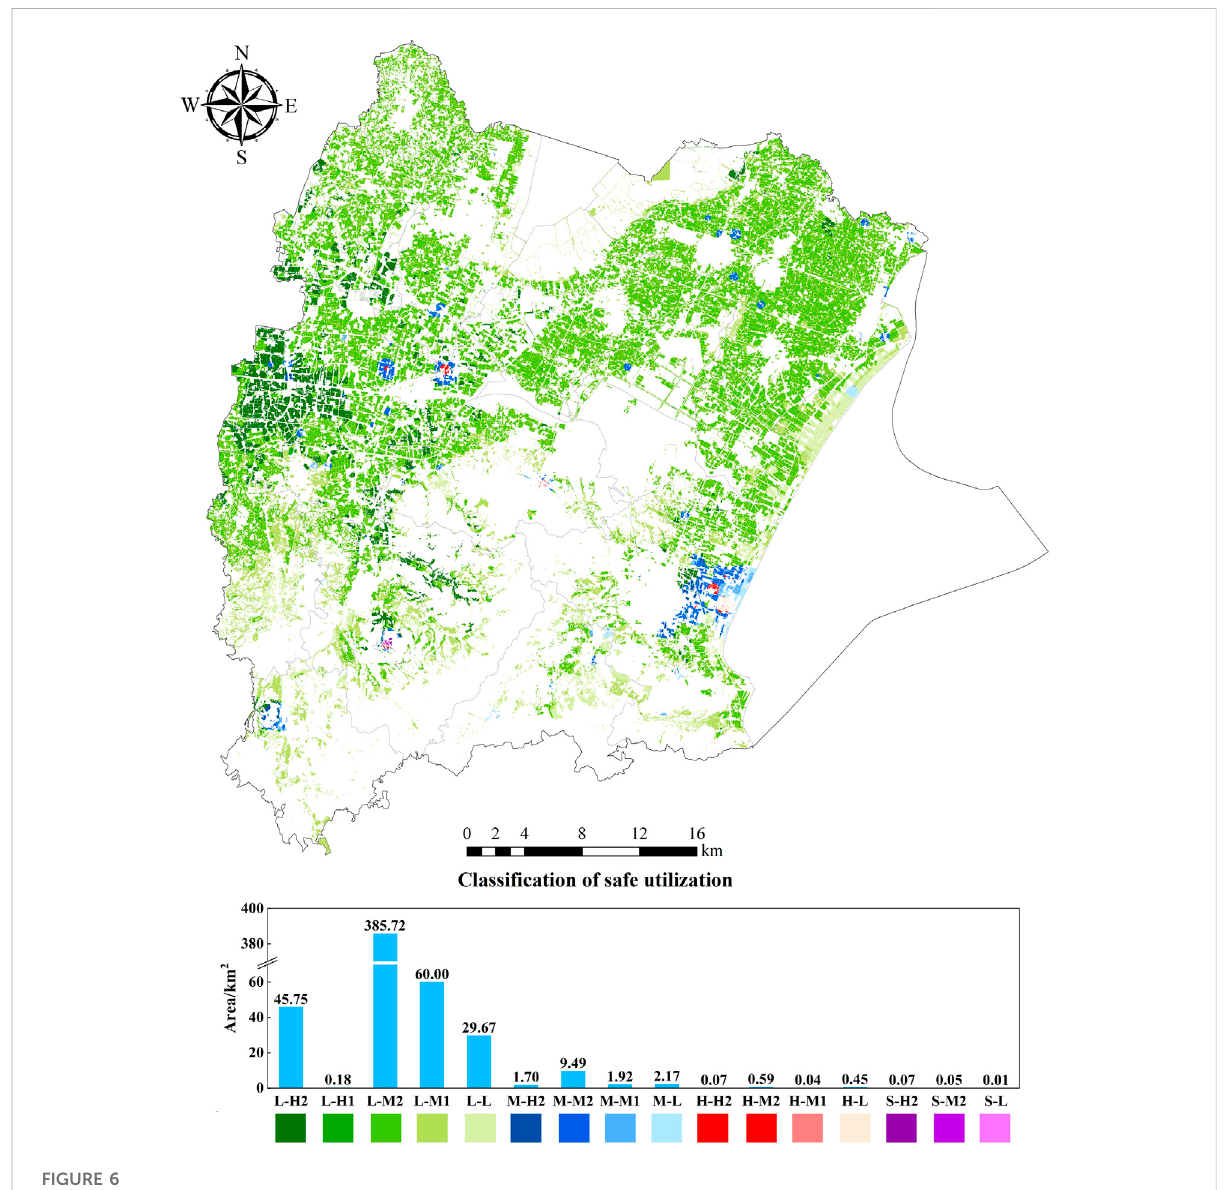
FIGURE 6 Classi fi cation of the safe utilization of cultivated